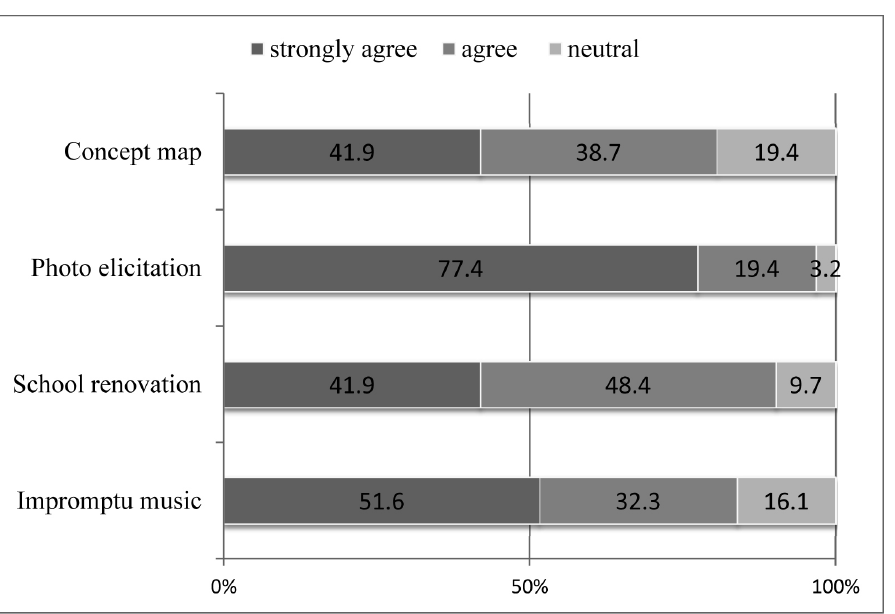
Figure 3: Students agreeing each lesson was